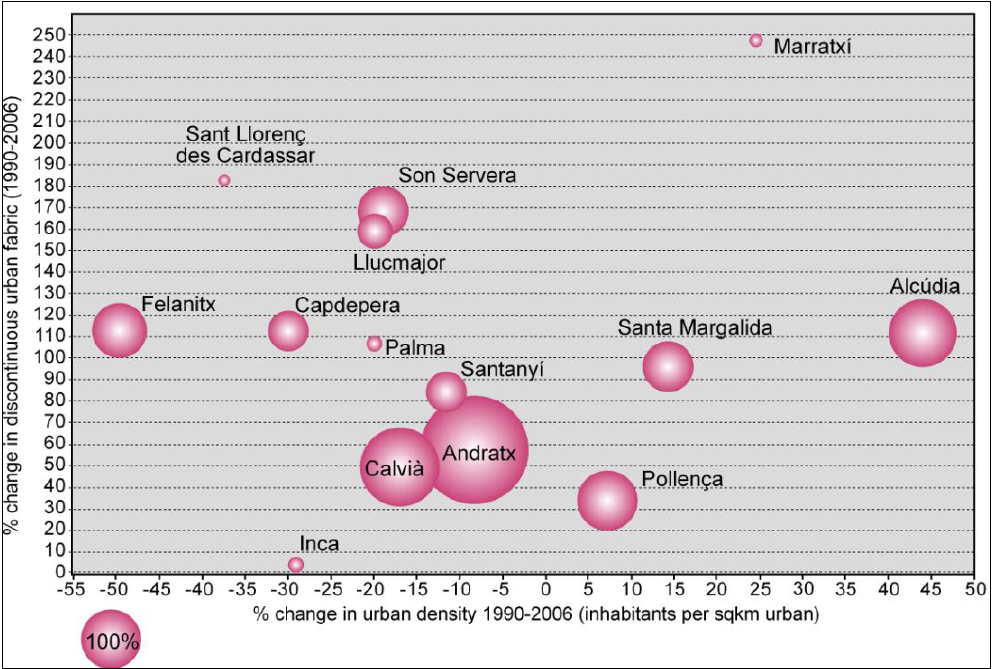
Figure 5. Ratio of second homes to principal residences (radius of the bubble) plotted against change (1990–2006) in discontinuous urban fabric (y-axis) and change in urban density (x-axis) in selected municipalities in Majorca. Data source: Own calculations based on